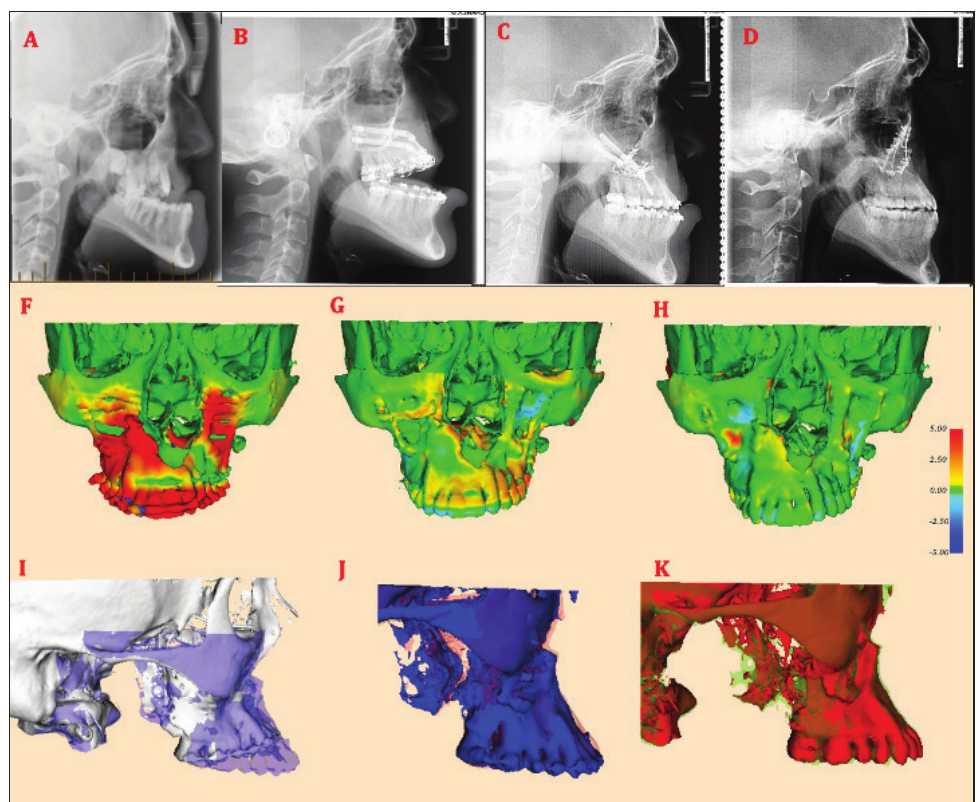
Figure 3. Lateral cephalogram radiographs and Cone Beam Computed Tomography (CBCT) imaging (A) Pre-orthodontics (B) Distractor placement and initial activation (C) Post-distractor activation and pre-Le Fort I (D) 2.4 year follow-up after orthodontic appliances were removed F&I. CBCT superimposition distractor placement and post-distractor activation G&J. CBCT superimpositions post-surgery and orthodontic appliance removal H&K. Post-surgery and 2.4 year follow